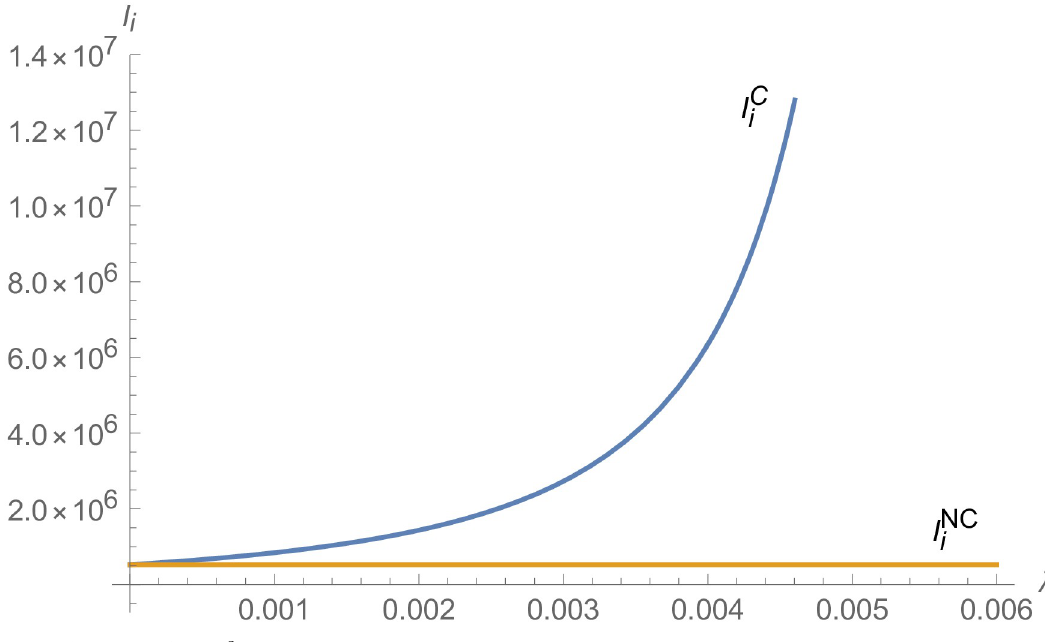
Fig 9. The impact of λ on I C